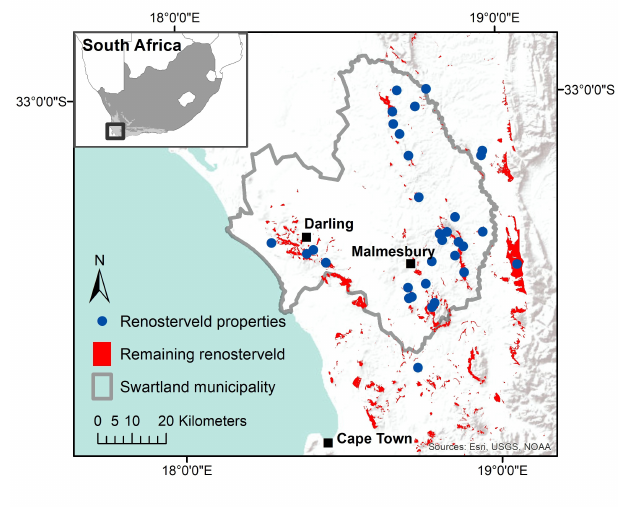
Fig. 1. Map showing the locations of the Swartland municipality, the remaining extent of renosterveld, and the participating land managers with renosterveld remnants on their land (renosterveld properties). Table 1. List of interview questions and their corresponding